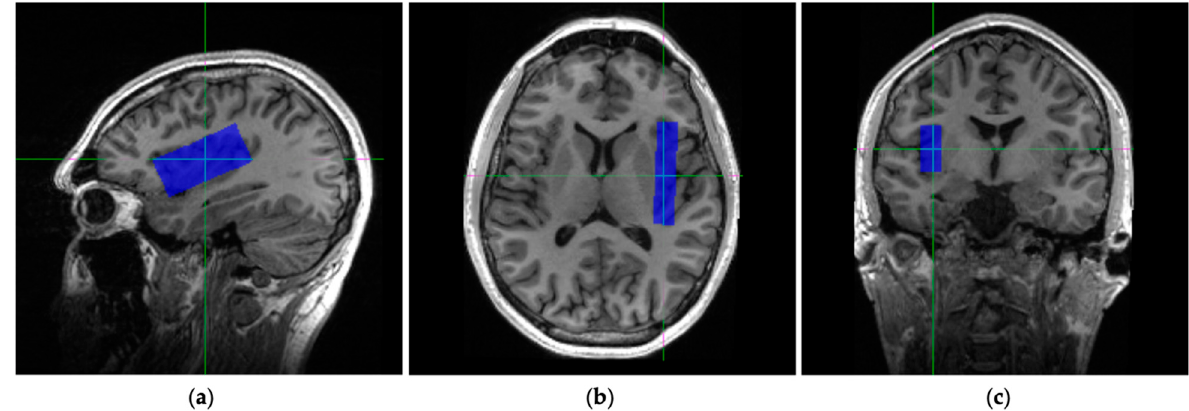
Figure 1. Images illustrating voxel placement of the insula. Voxel is placed 55 mm in anterior-posterior, 12 mm right-left, and 25 mm in superior-inferior direction (with 16.5 mL total volume). The voxel placement is presented in ( a ) sagittal, ( b ) axial, and ( c ) coronal views.